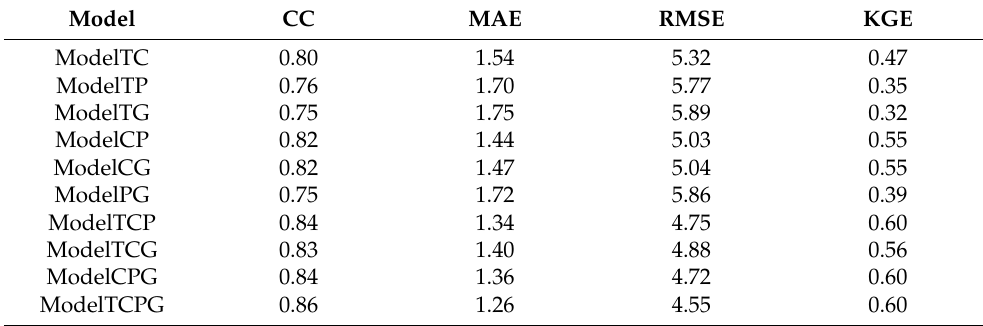
Table 7. Evaluation results of spatial precipitation estimation generated by the GWR-LSTM frame- work merging different combinations of satellite precipitation products and gauge observations.